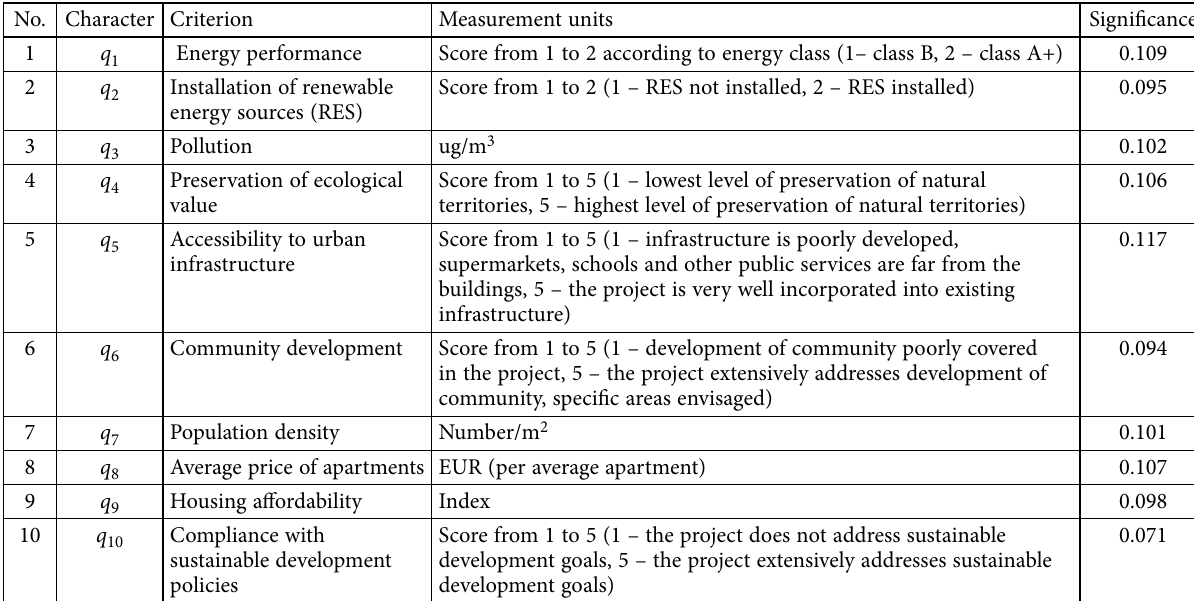
Table 2. Sustainability assessment